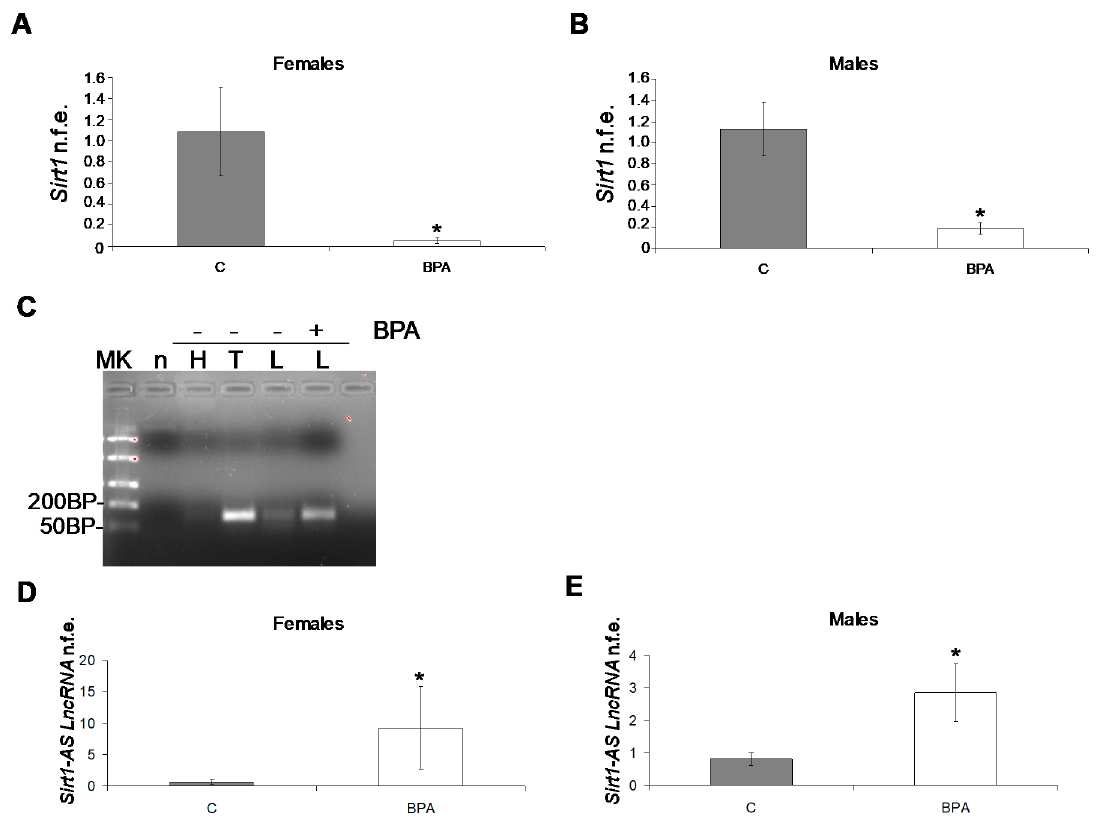
Figure 5. Sirt1 qPCR in male ( A ) and female young animals (60 PND) ( B ). Strand-specific PCR for the detection of Sirt1-AS LncRNA in rat tissues (MK, DNA ladder; n, negative control; H, heart, T, testis; L, liver; -BPA absence; + BPA presence) ( C ). Quantitative PCR analysis for Sirt1 - AS LncRNA in male ( D ) and female young animals (60 PND) ( E ). qPCR data are expressed as normalized fold expression (n.f.e.) ± SE, reference gene Gapdh ; reference sample arbitrarily assigned value 1, control group ( n = 6, 3 males and 3 females, * p < 0.05).